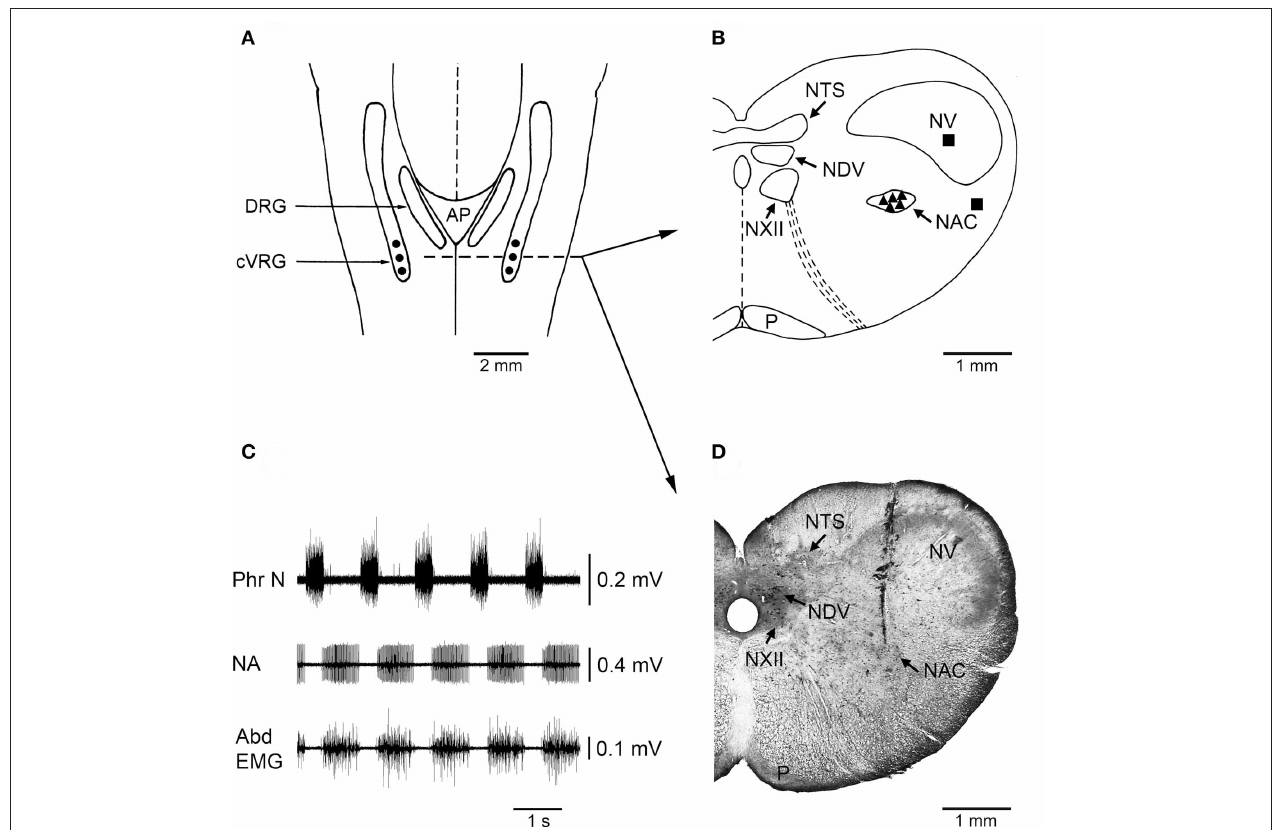
FIGURE 1 | Localization of injection sites and histological control. (A) A diagrammatic representation of a dorsal view of the medulla oblongata of the rabbit showing where bilateral microinjections of bicuculline or muscimol were performed into the cVRG ( • ). AP, area postrema; cVRG, caudal ventral respiratory group; DRG, dorsal respiratory group. (B) Diagram of a coronal section of the medulla oblongata at the level indicated in panel A (dashed line) showing the location of representative sites ( (cid:2) ) where the microinjections of 1mM bicuculline were performed. The diagram also shows the location of some control injection sites ( (cid:3) ) where bicuculline caused no appreciable changes in the pattern of breathing and